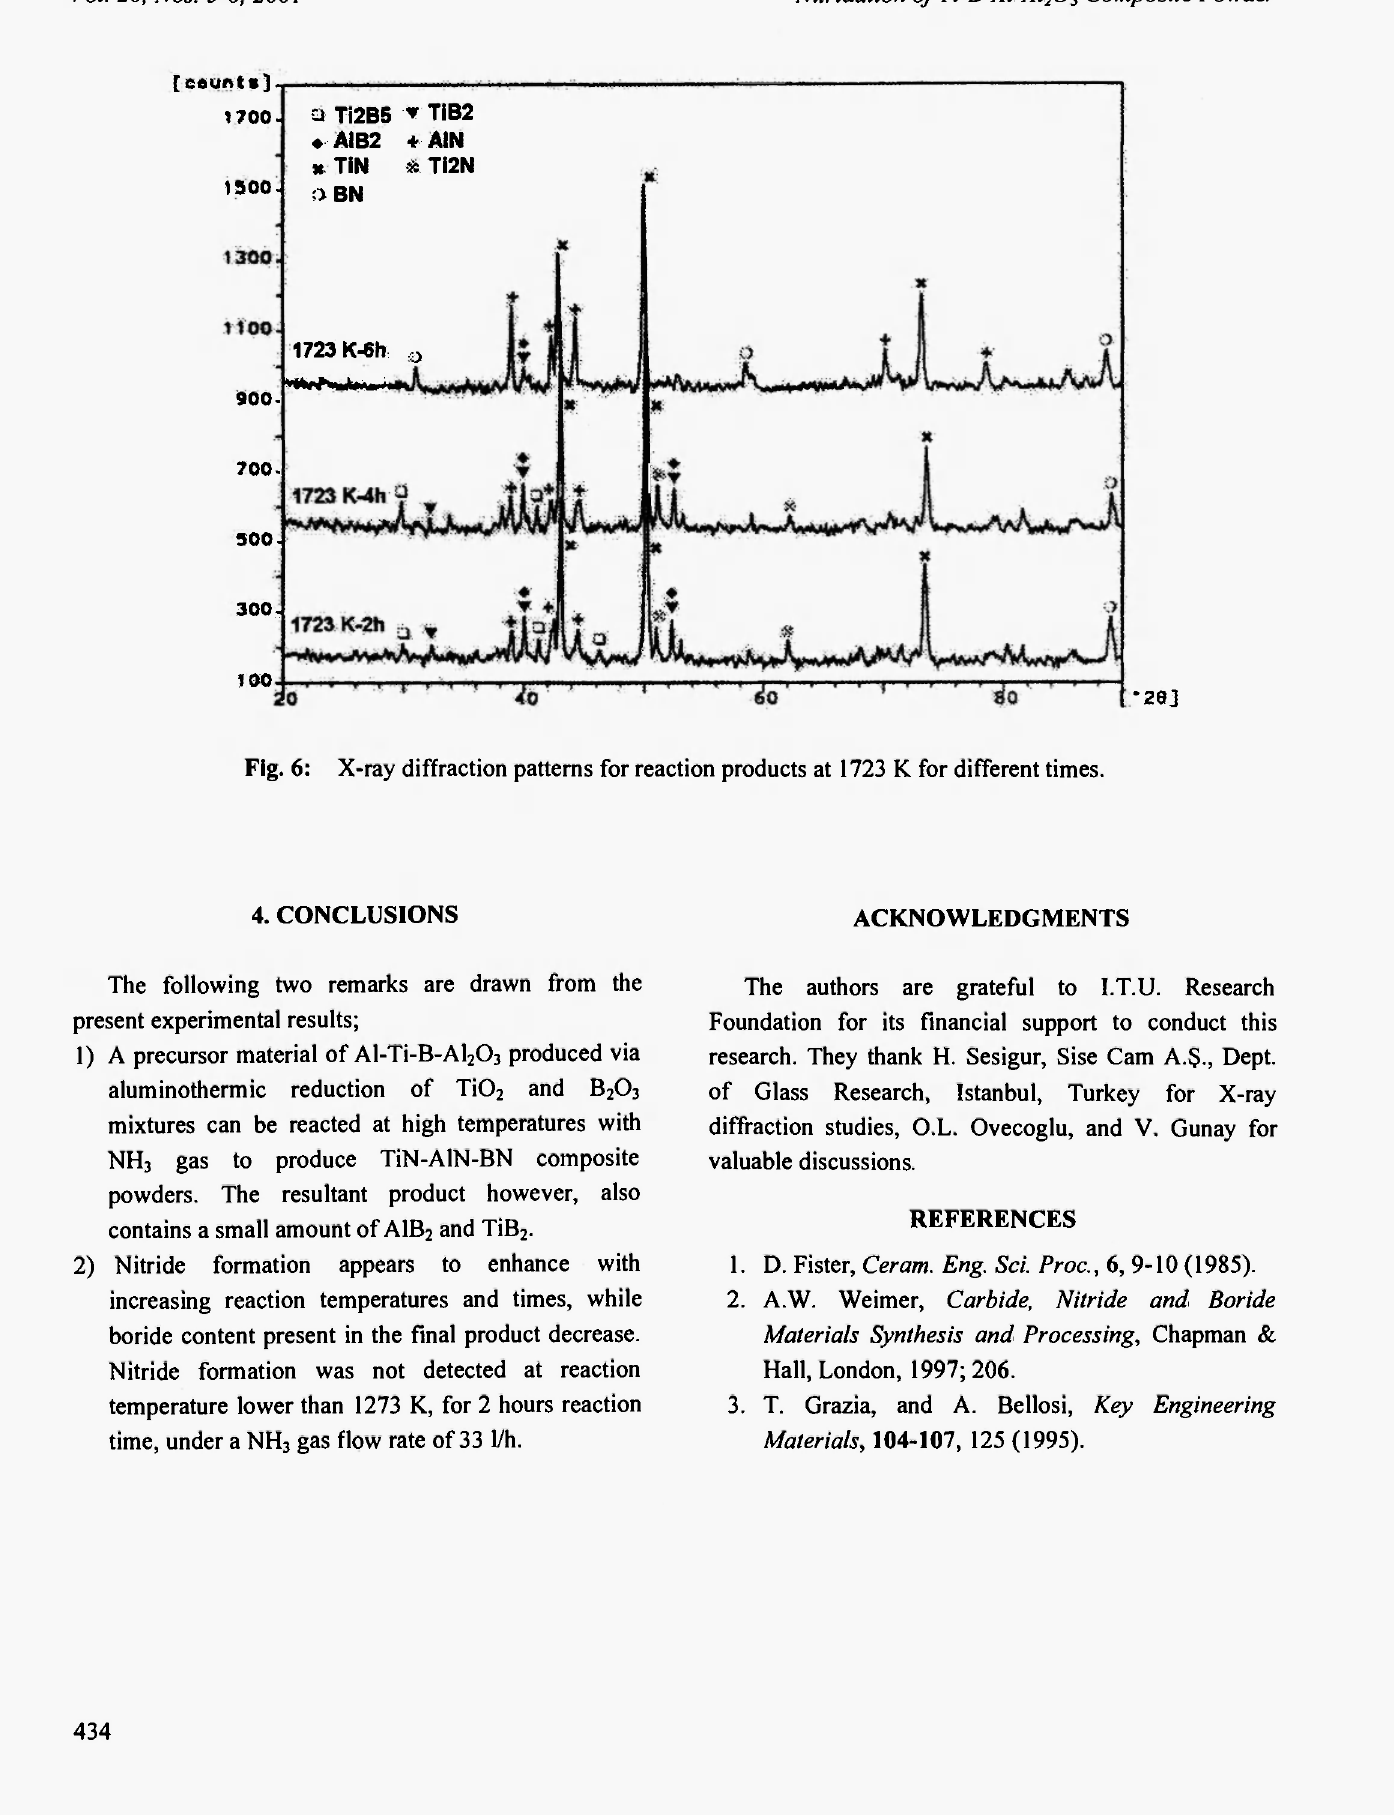
Fig. 6: X-ray diffraction patterns for reaction products at 1723 Κ for different